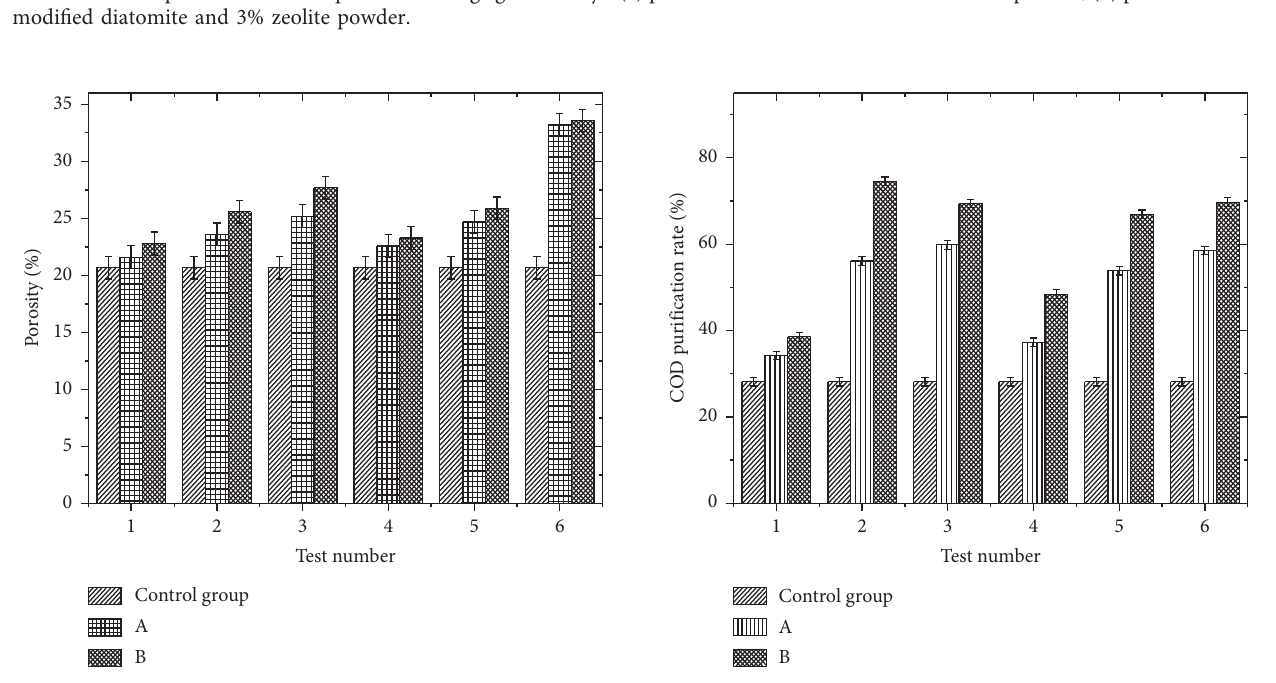
Figure 5: COD purification effect of permeable concrete. Note: A- 1 ∼ A-6: permeable concrete specimens with unmodified diatomite and zeolite powder in different dosages; B-1 ∼ B-6: permeable concrete specimen with modified diatomite and zeolite powder in different